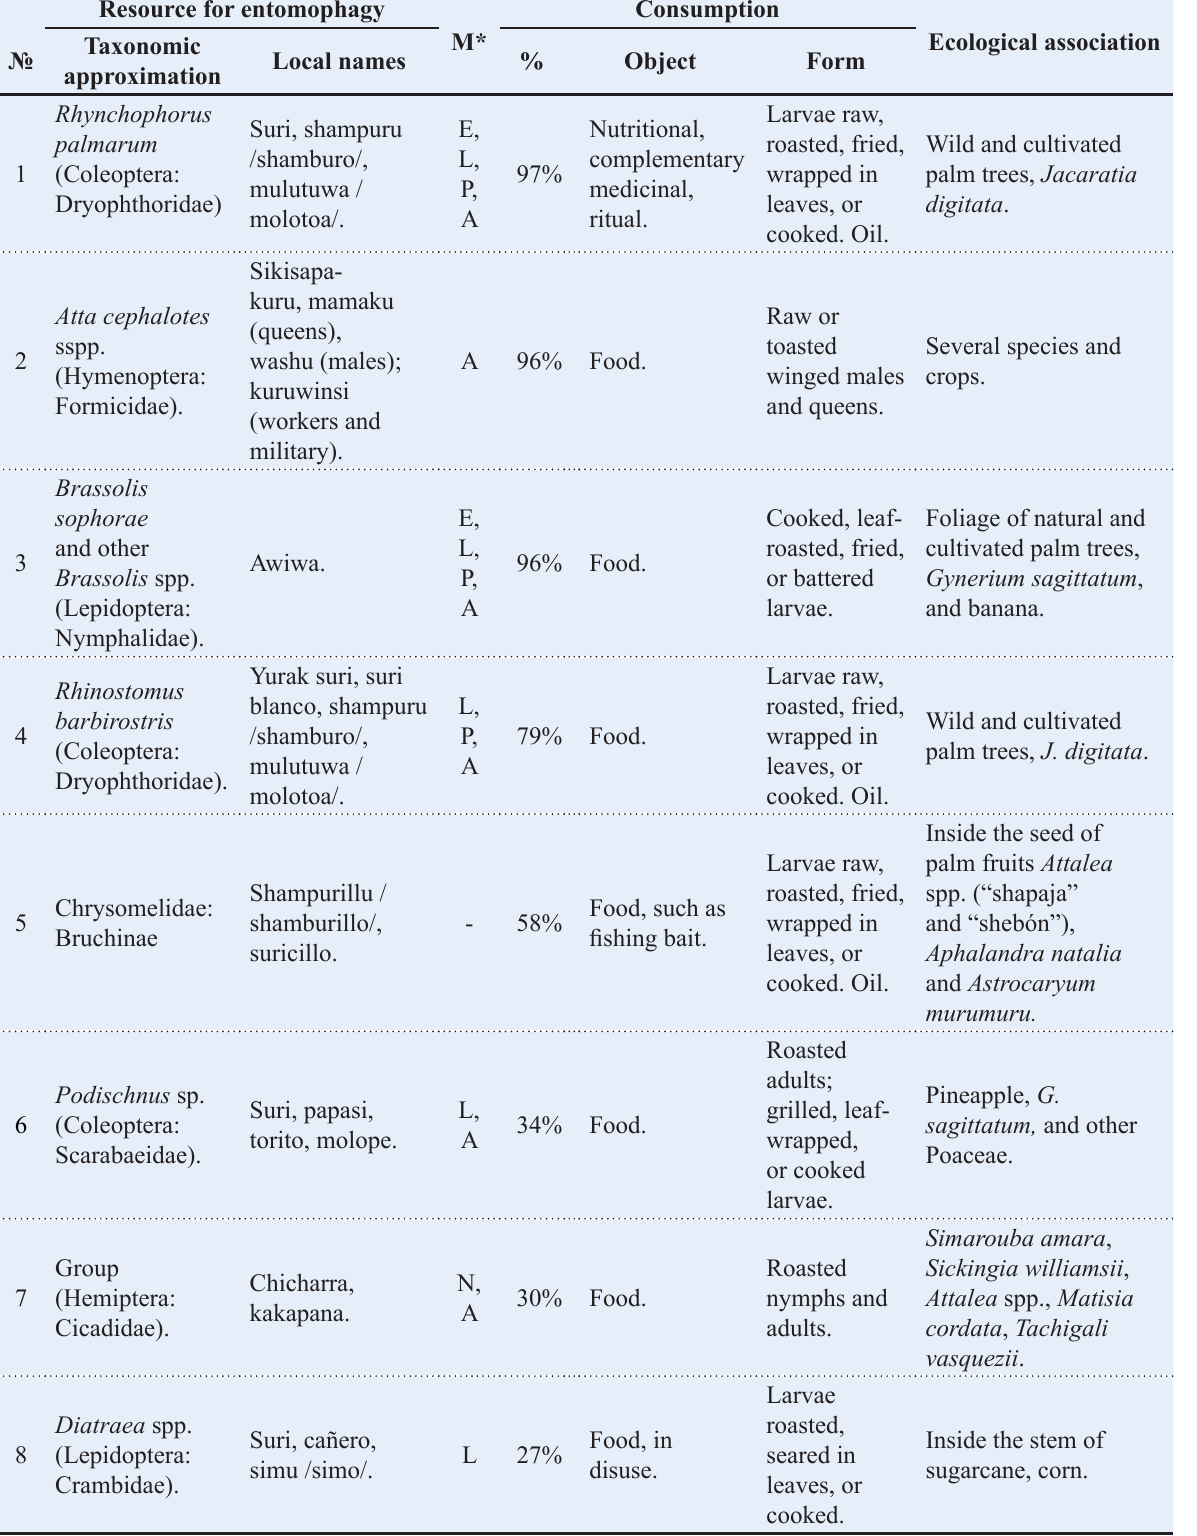
Table 1. Resources for entomophagy in San Martin